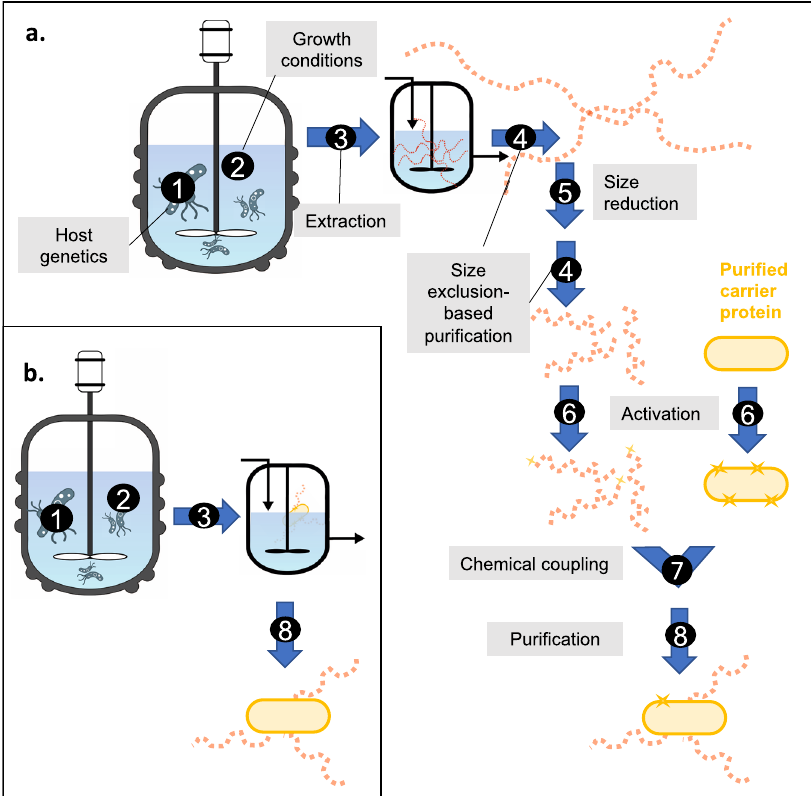
Fig. 3 Glycan chain length depends on a number of factors and conditions applied during glycoconjugate vaccine production. a Standard glycoconjugate vaccine production process. b Bioconjugation process. Critical junctures are indicated by numbers. 1. Genetics of the bacterial strain employed. The bioconjugation process includes all genetic modi fi cations introduced to the glycoconjugate production strain to facilitate in vivo coupling of the glycan to a carrier protein. 2. Growth conditions. 3. Strategies for isolation and puri fi cation of the glycan (or, in bioconjugation, of the conjugate). 4. Size-exclusion-based glycan or glycoconjugate puri fi cation procedures, such as tangential fi ltration (TFF) or size-exclusion chromatography. 5. Chemical or physical glycan size-reduction protocols, such as acid hydrolysis, ozonolysis, micro fl uidization, and/or periodate oxidation. 6. Activation chemistries of glycan and carrier protein. 7. Conditions applied for the chemical coupling of carrier and glycan. 8. Puri fi cation via combinations of chromatographic techniques, such as ion exchange and hydrophobic